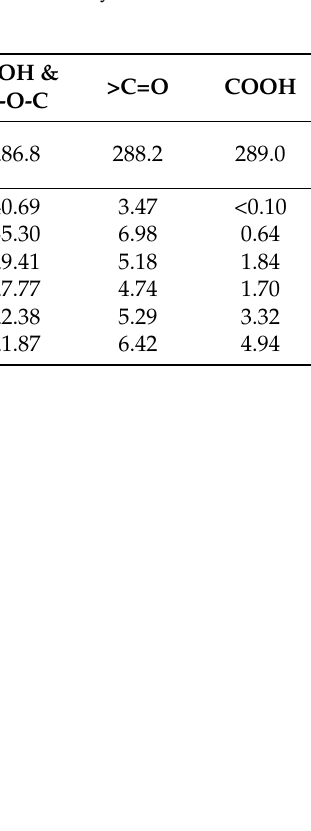
Figure 3. The changes in the concentration of the basal-plane (C-OH&C-O-C) and carboxyl (COOH) groups upon the change of the relative concentration of the of KMnO 4 and K 2 Cr 2 O 7 oxidizing agents. Table 2. C/O ratio, and the composition of the functional groups and carbon atoms in the graphene network (in at.%) in the MC#1–MC#6 films derived from the analysis of the deconvoluted C 1s X-ray photoelectron spectra. Component